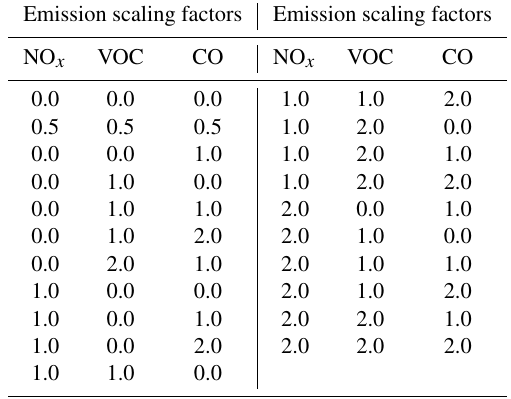
Table 2. List of emission variation simulations performed with EMAC for each emission region. This set is used as input for the LUTs for